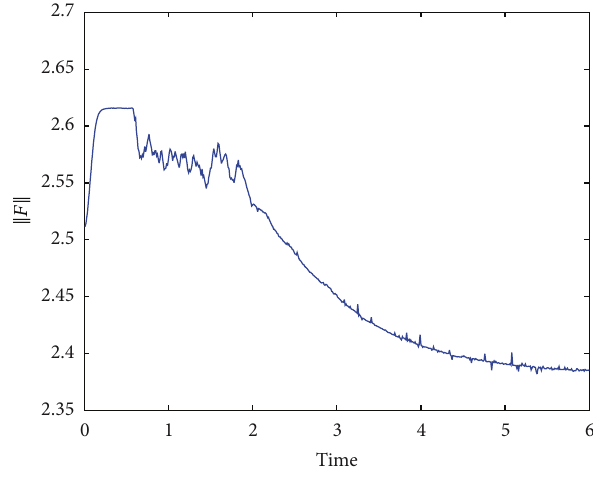
Figure 6: Feedback matrix norm for Example 13.